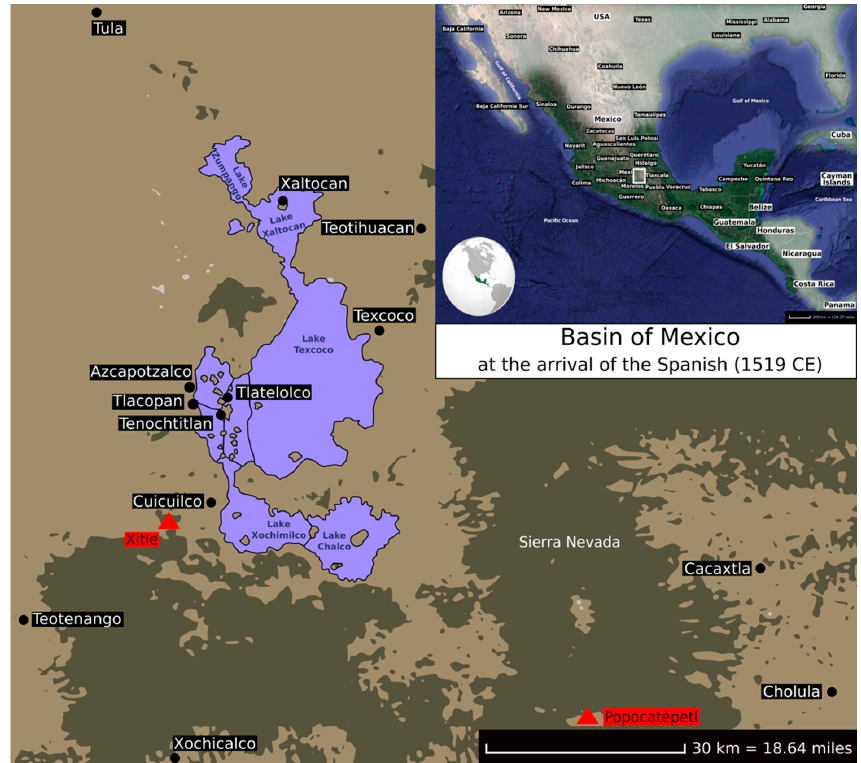
Figure 2. Approximate locations of the archaeological sites (black dots) and volcanoes (red triangles) in the Basin of Mexico at the arrival of the Spanish (1519 CE), as discussed in the present review.